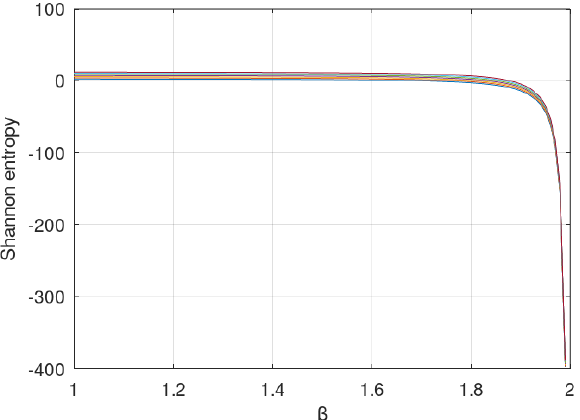
Figure 5. Shannon entropy as function of β ∈ ( 1,1.99 ) for t = 5 n , n = 0,1, · · ·